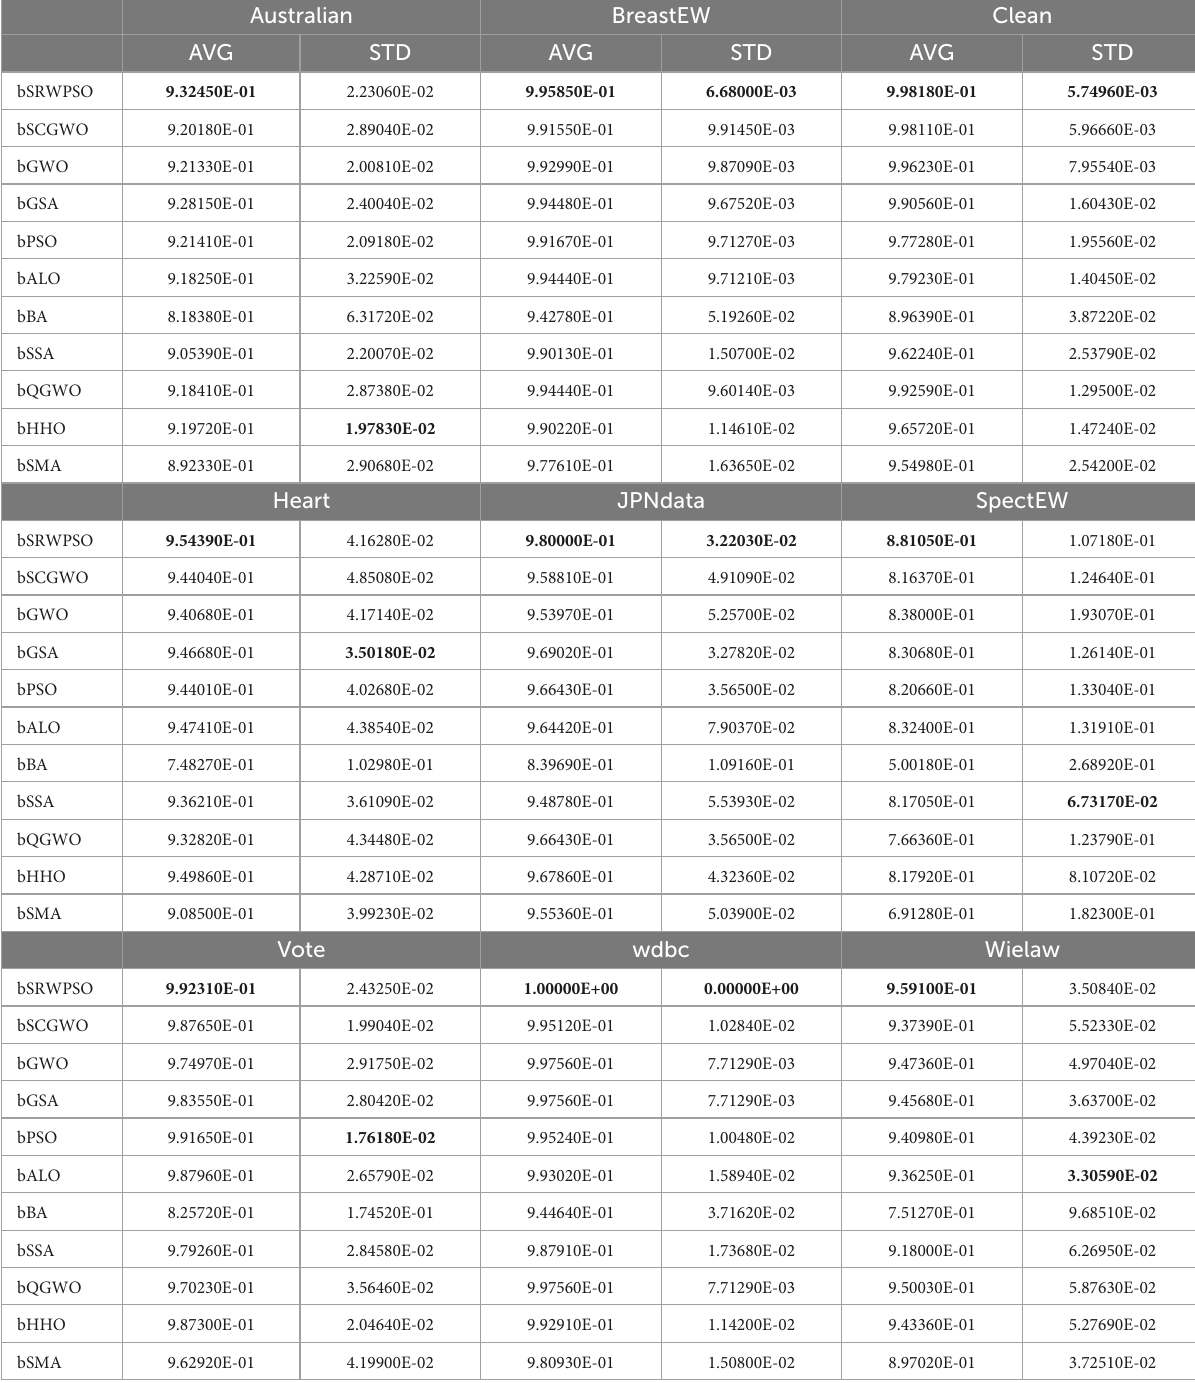
TABLE 19 The analysis results of